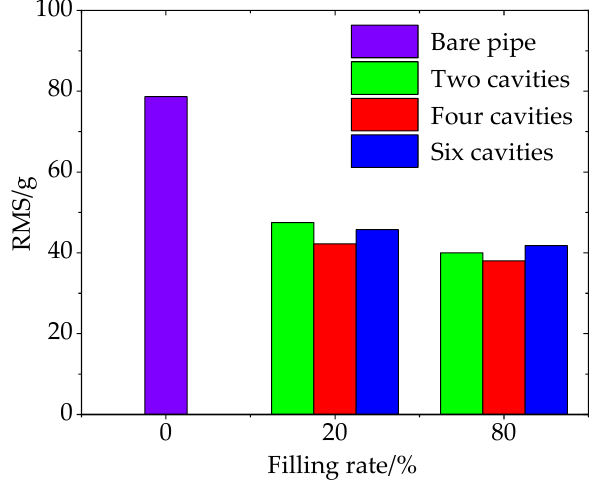
Figure 15. Comparison of frequency response with different cavities at the ( a ) 20%, ( b ) 80% filling rate.